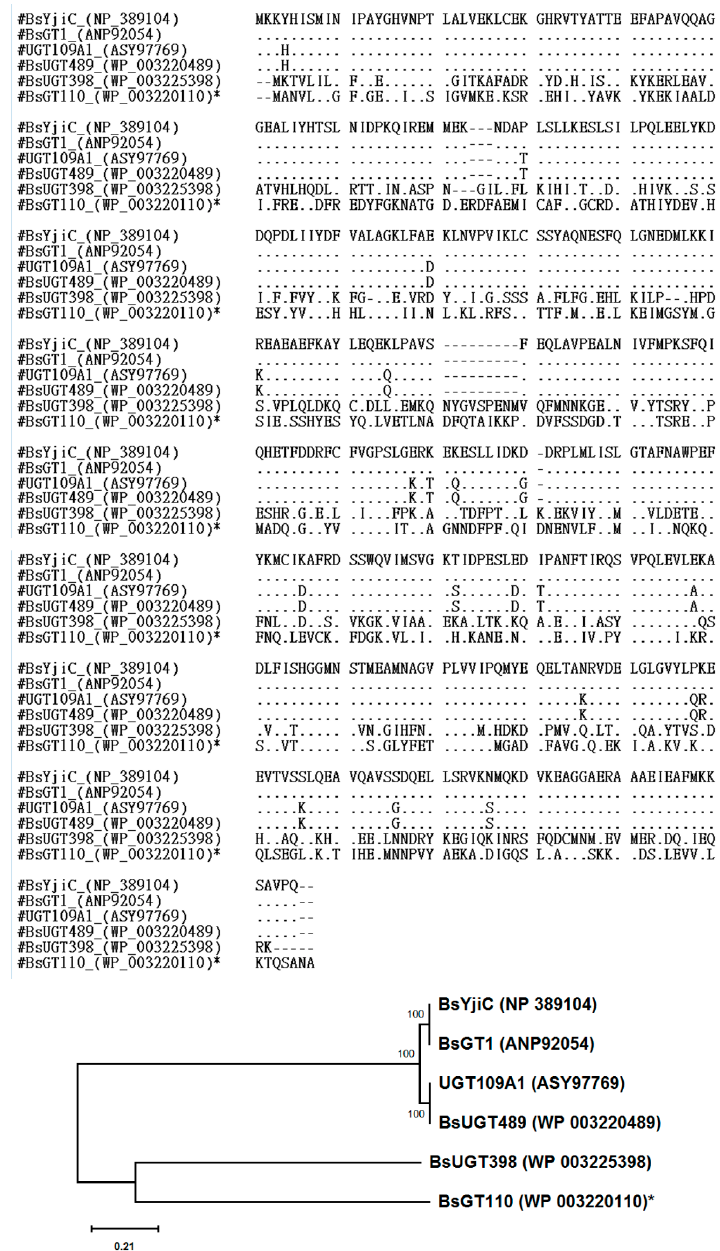
Figure 6. Aligned amino acid sequences and phylogenetic analysis using the Maximum Likelihood method. In total, 407 amino acids were aligned by Clustal W in MEGA X [27]. ‘.’ denoted as identical amino acid, ‘-’ denoted as indel(s). The phylogenetic tree was inferred using the Maximum Likelihood method and General Reversible Mitochondrial model [28]. The tree with the highest log likelihood ( − 3197.28) was shown. The percentage of trees in which the associated taxa clustered together was shown next to the branches. Initial tree(s) for the heuristic search were obtained automatically by applying Neighbor-Joining and BioNJ algorithms to a matrix of pairwise distances estimated using the JTT model, the topology with highest log-likelihood value was then selected. The tree was drawn to scale, with branch lengths measured based on the number of substitutions per site. This analysis involved six amino acid sequences. All positions with less than 95% site coverage were eliminated—i.e., less than 5% alignment gaps, missing data, and ambiguous bases were allowed at any position (partial deletion option). There were a total of 382 positions in the final dataset. Evolutionary analyses were conducted in MEGA X [27].